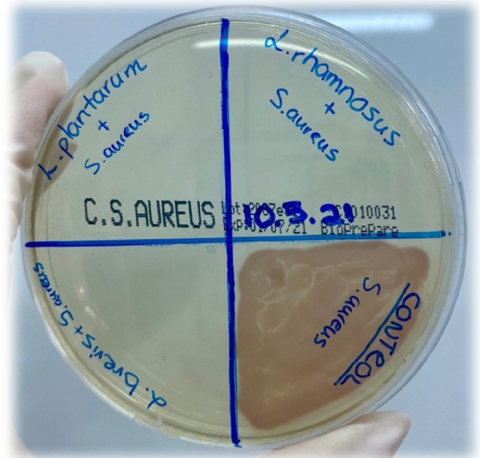
Figure 9. The results of the antimicrobial activity of CFCs (after 5 days incubation) of three LAB species ( Levilactobacillus brevis, Lactiplantibacillus plantarum, Lacticaseibacillus rhamnosus ) against pathogenic bacteria S. aureus ATCC 29213.